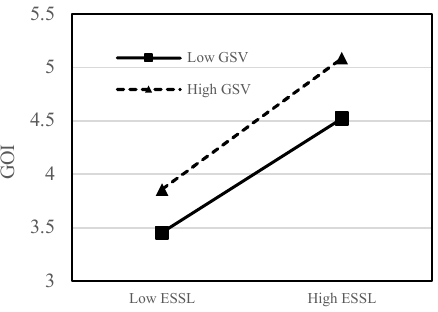
Figure 3. The moderating effect of GSV on the relationship between ESSL and GOI.